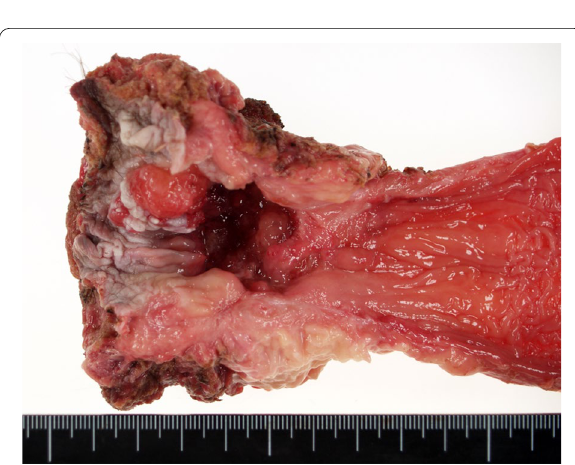
Fig. 4 Macroscopic examination shows type 2 tumor located in the lower rectum. Tumor diameter is 40